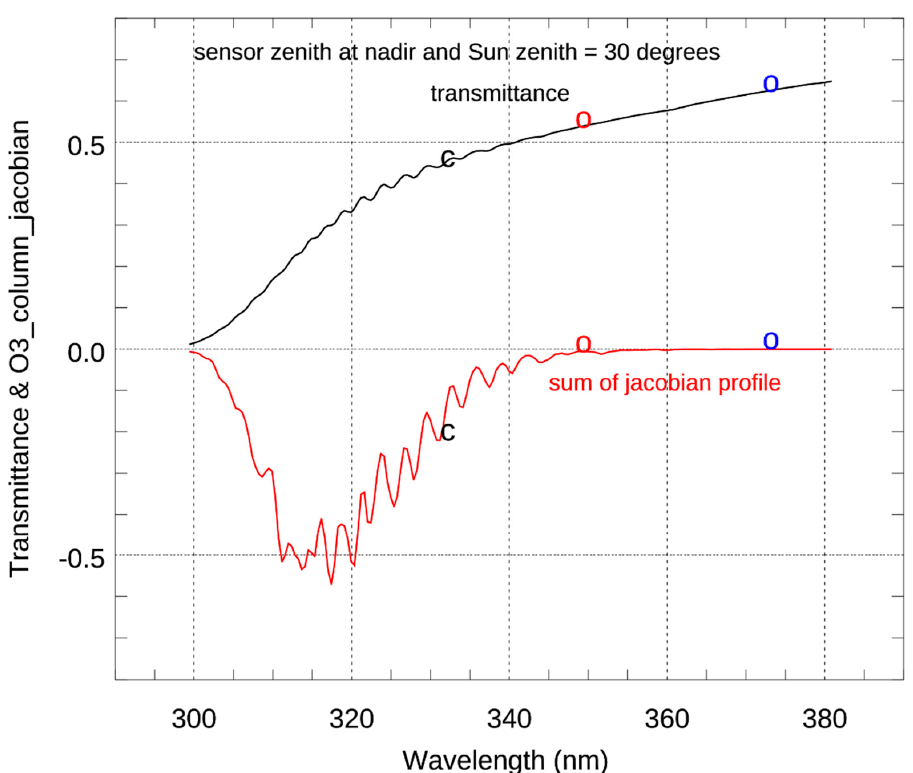
Figure 5. Total transmittance from surface to satellite (black line). The red line is the accumulated CRTM Jacobian radiance to ozone profile. Symbol “c” is the position at 331 nm used to estimate surface reflectance. The symbol “o” are the two channels that we propose to estimate the surface reflectance. The surface reflectance for other channels is either interpolated or extrapolated from the two reflectance points at 347.6 nm and 371.8 nm.